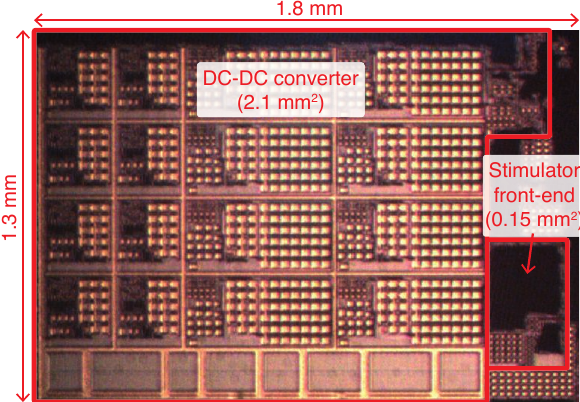
Figure 10. Microphotograph of the fabricated chip.